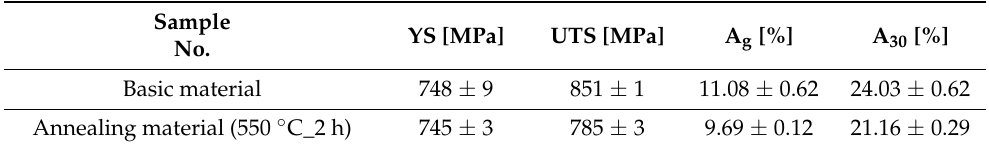
Table 2. Mechanical properties of tested material S700MC.